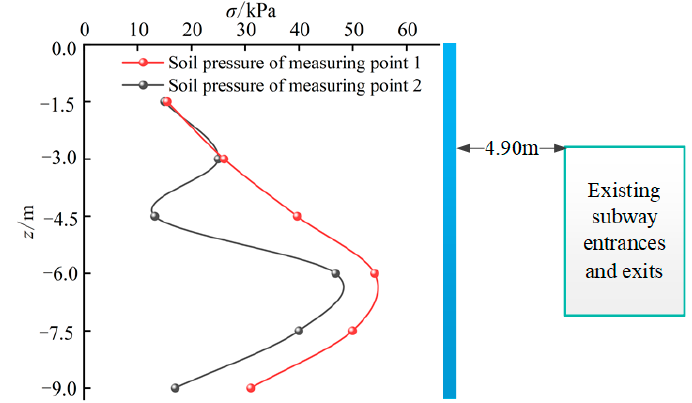
Figure 2. Comparison of soil pressure distribution.